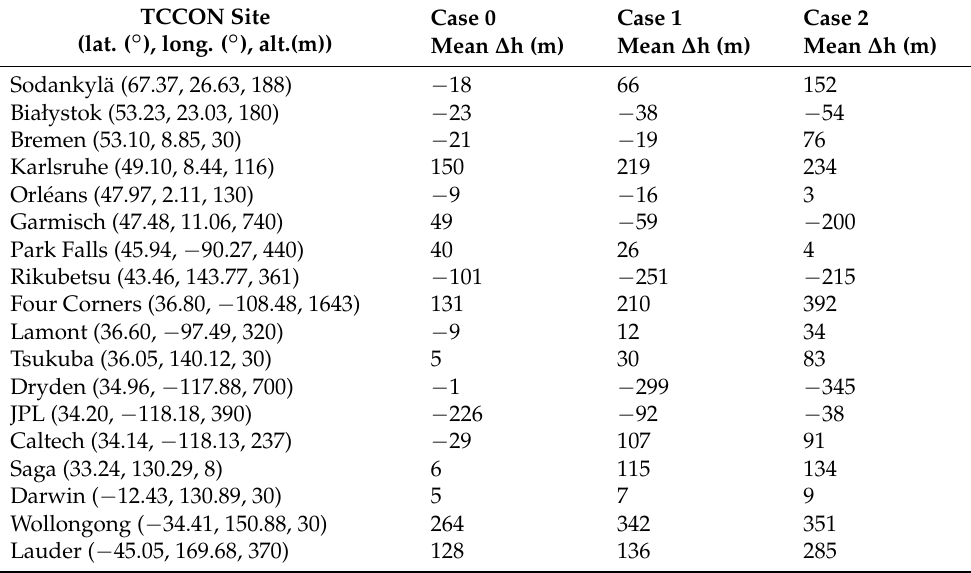
Figure 2. Scatter plots between original GOSAT SWIR XH 2 O data and TCCON XH 2 O data for case 1 (GOSAT data retrieved within ± 1 ◦ latitude/longitude boxes centered at each TCCON site and the mean of TCCON XH 2 O values within ± 30 min of the GOSAT overpass time) at the 18 TCCON sites from April 2009 to December 2017. GOSAT land data (gain H) are shown by red circles and GOSAT mixed data (gain H) are shown by black circles. The regression lines fitted to the data are dotted and the solid lines show one-to-one correspondence. Table 4. Differences in mean altitude between the GOSAT SWIR XH 2 O observation point and each TCCON site for the three colocation cases. Both gain M and gain H land and mixed data were used to calculate the altitude differences.